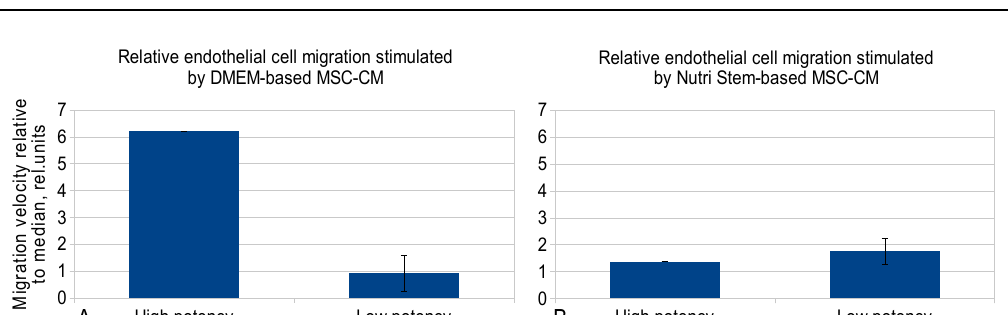
Figure 6. Comparison of two groups of MSC-CM samples that differed in potency to stimulate human endothelial cell migration. A —Samples manufactured using DMEM-LG, n = 1 for High potency group, n = 4 for Low potency group; B —NutriStem, n = 1 for High potency group, n = 4 for Low potency group. The data are presented as means ± SD.